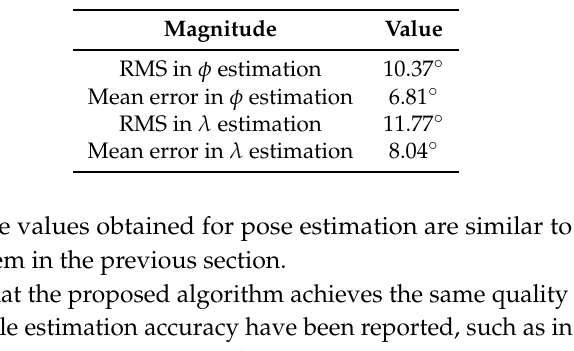
Table 5. Results computed removing false positives.